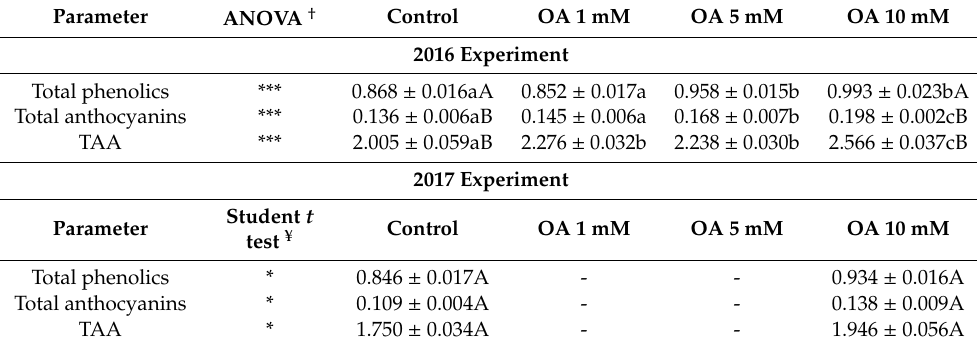
Table 3. E ff ects of preharvest oxalic acid (OA) treatments (1, 5, and 10 mM) on bioactive compound concentration, total phenolics and total anthocyanins, and total antioxidant activity (TAA; g kg − 1 ) in the first picking date in 2016 and 2017 experiments. Data are the mean ±